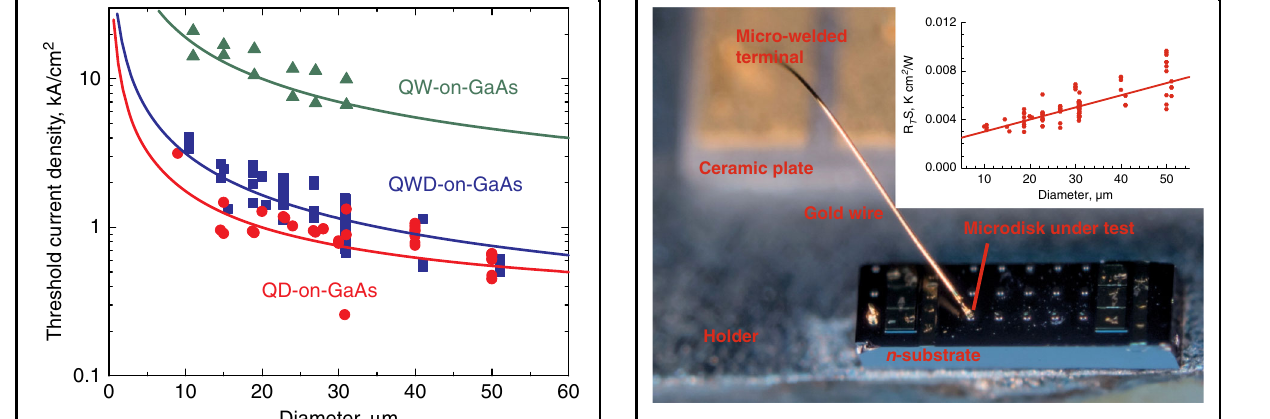
Fig. 12 Thermal resistance. Main panel: chip with several microdisks of different sizes, mounted on holder, with wire welded to tested microdisk. Inset: thermal impedance by microdisk area as a function of